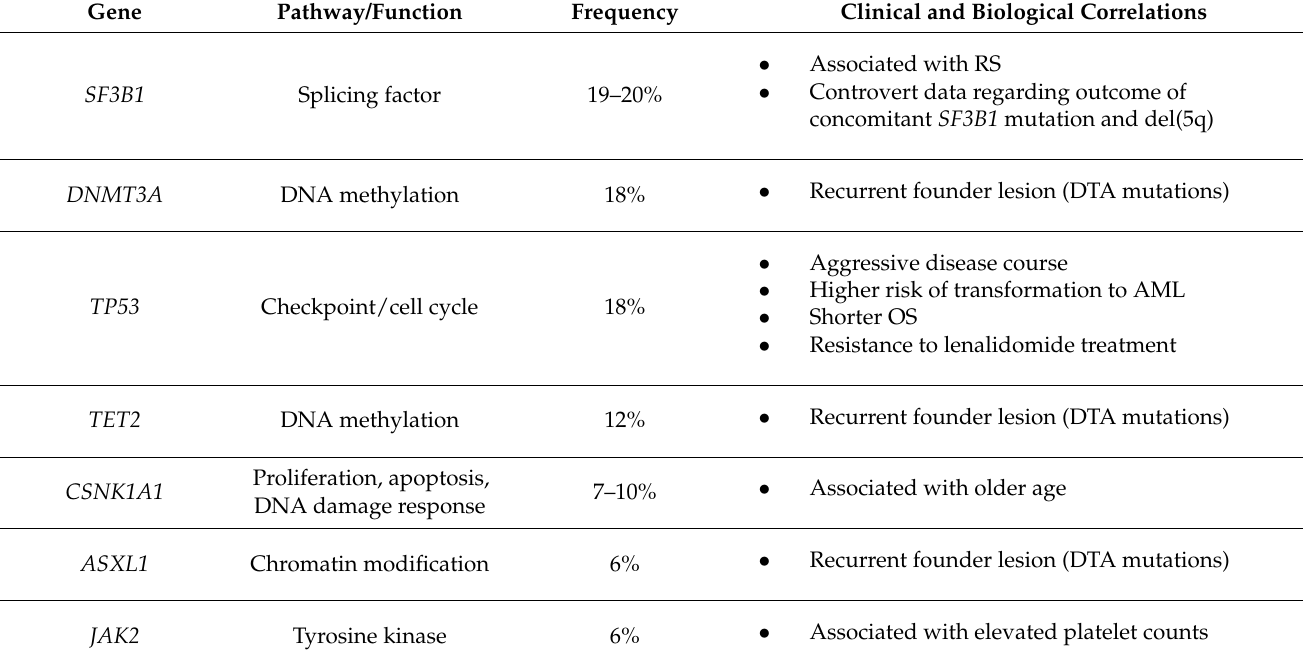
Table 1. Recurrently mutated genes in MDS-5q: clinical and biological